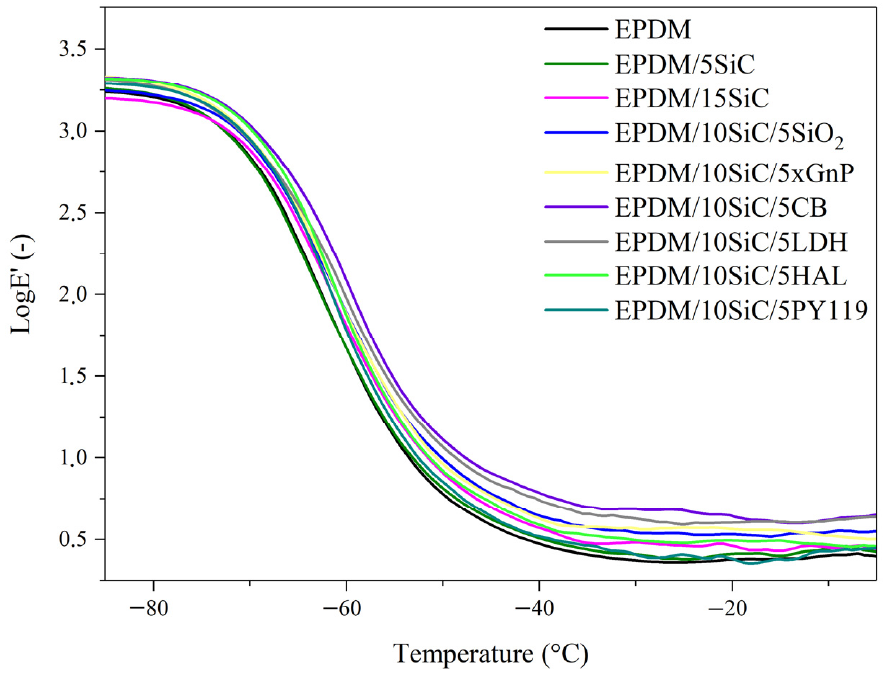
Figure 7. Storage modulus versus temperature curves obtained in DMA measurements for EPDM- filled composites.